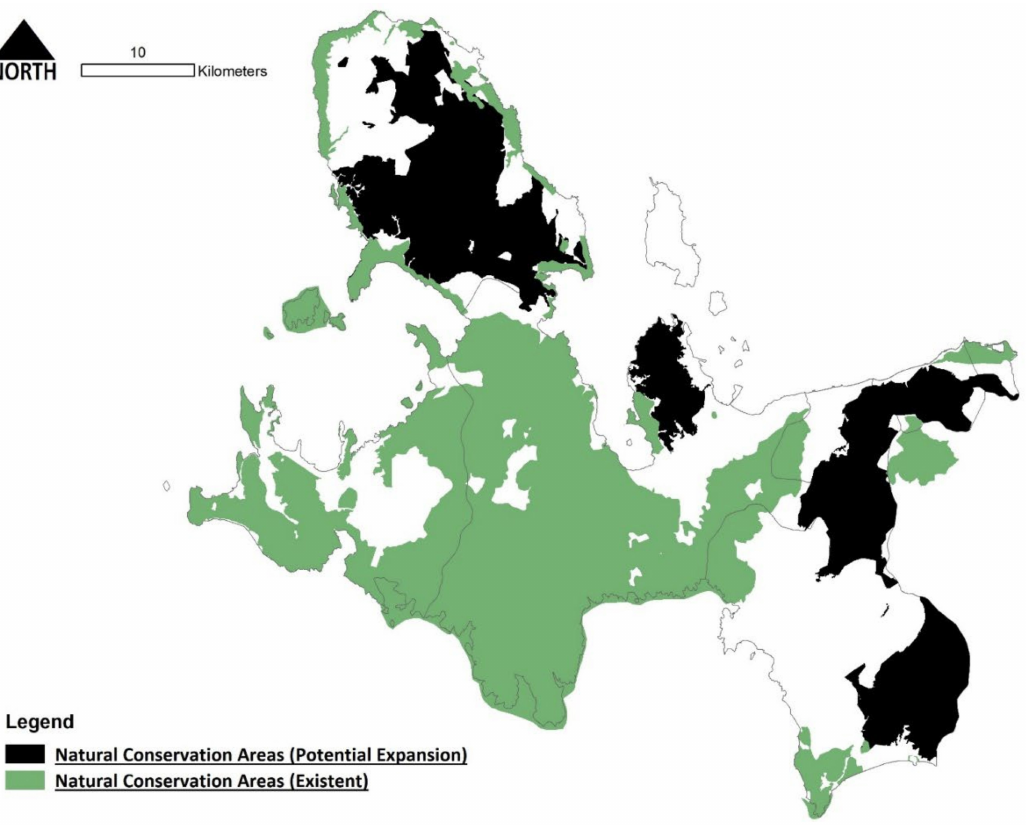
Figure 11. The potential inclusion of new Conservation Zones (black) in the Environmental Regula- tion